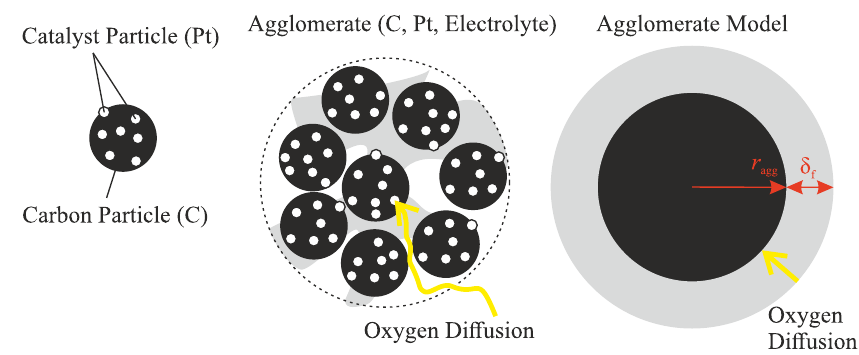
Figure 6. Agglomerate model visualisation showing the catalyst particles supported on the carbon support and an agglomerate of several carbon particles bound by the electrolyte. This agglomerate is represented by the simplified agglomerate